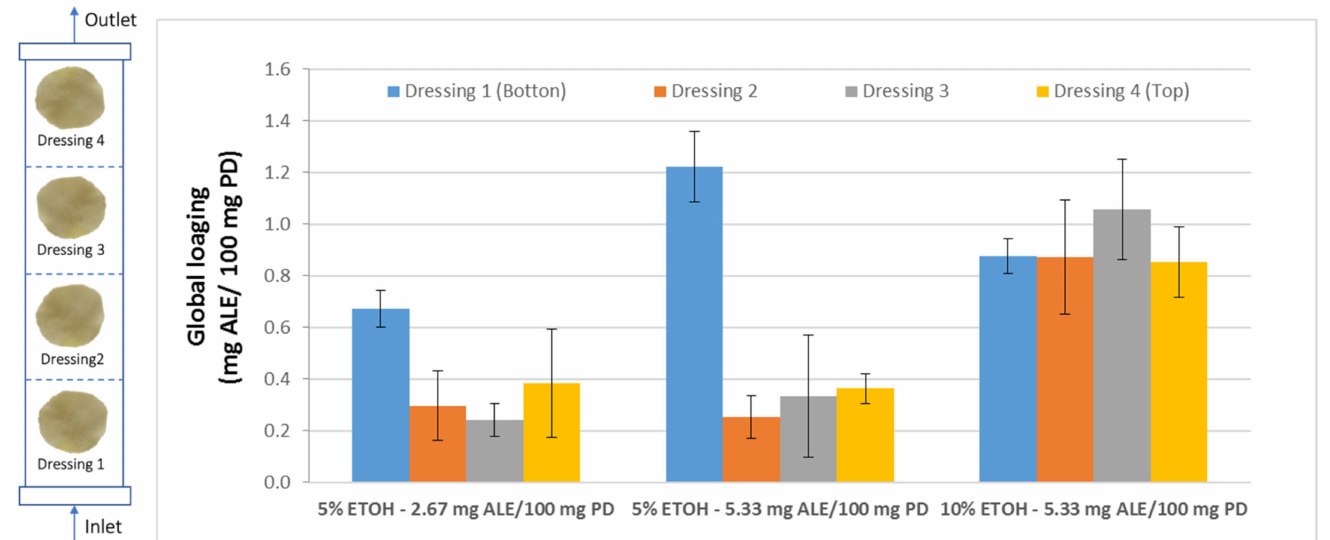
Figure 6. Total impregnation loadings of the samples located at four different heights inside the reactor and using three different configurations for ethanol percentage and ALE/polymer mass